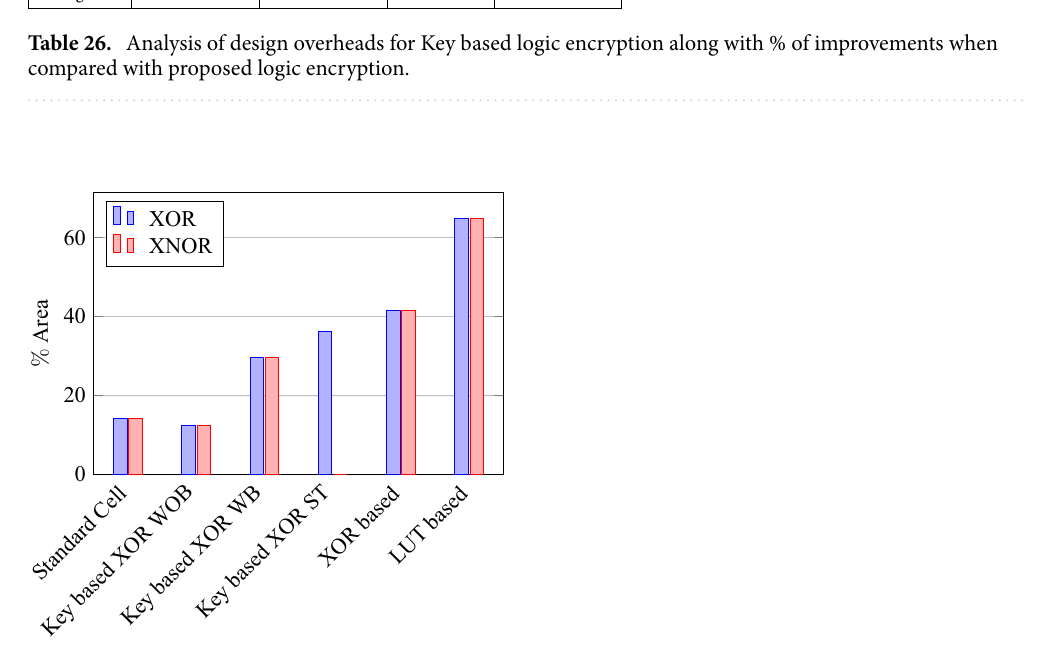
Figure 43. % of Change in area for XOR & XNOR gates compared to proposed design.